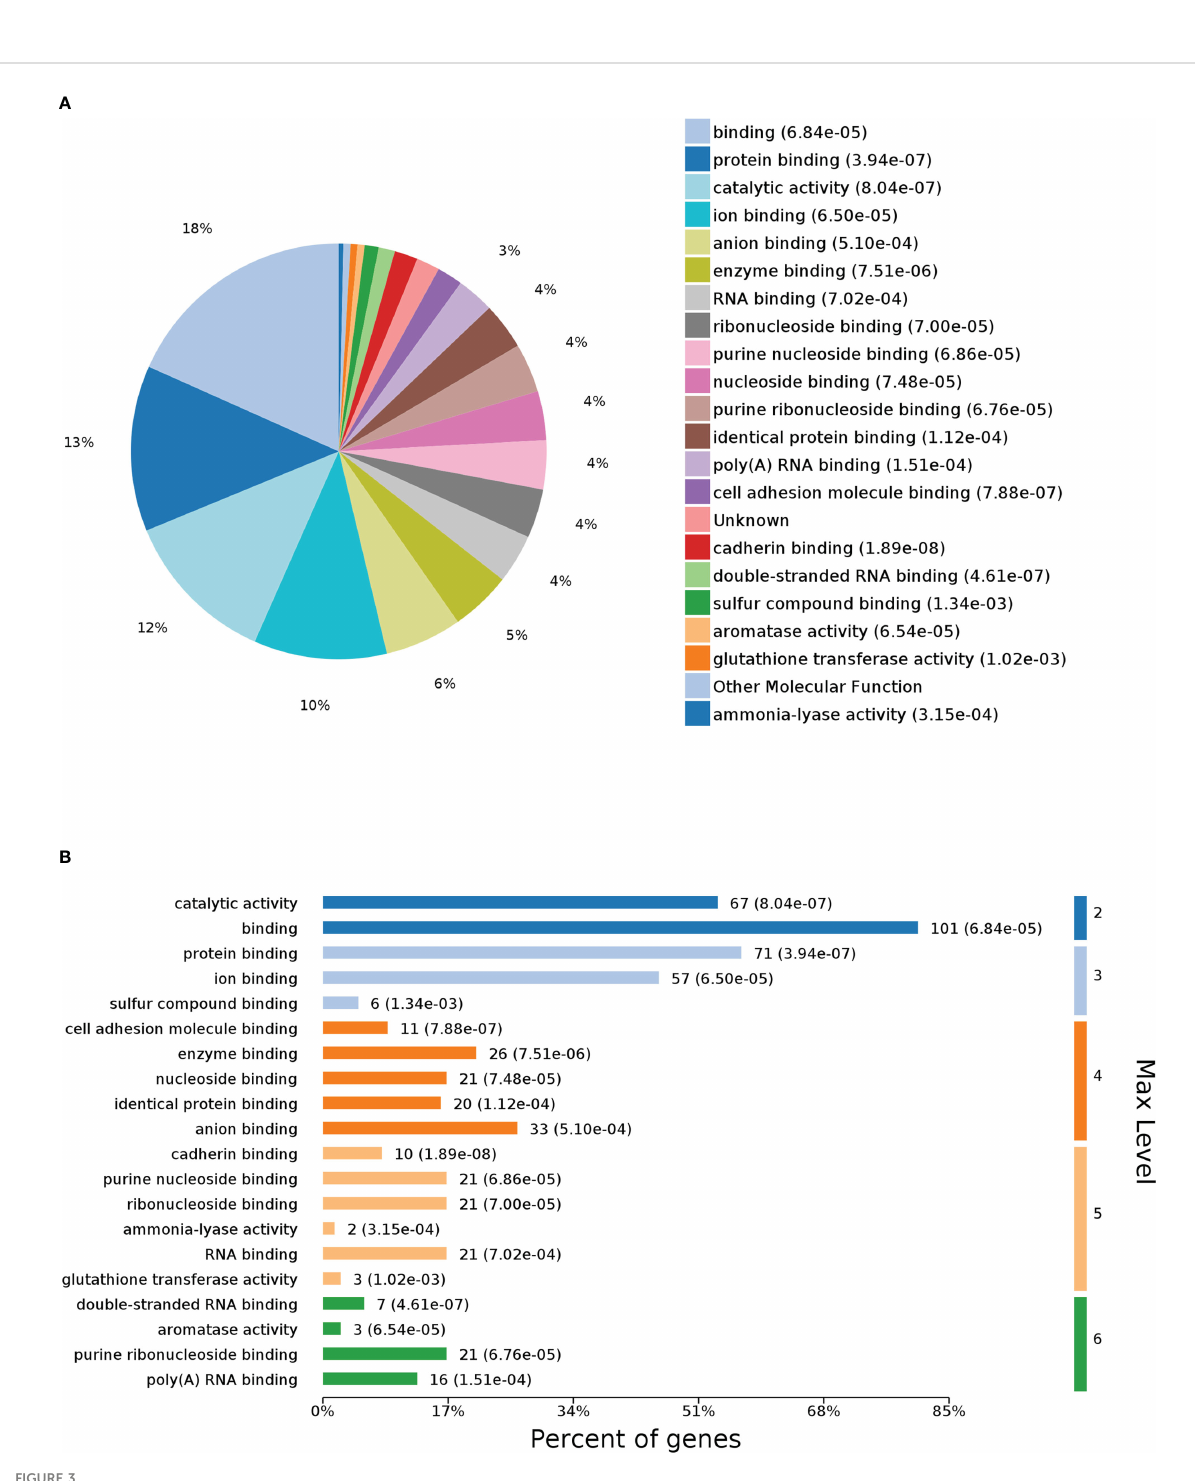
FIGURE 3 Gene Ontology (GO) enrichment analysis of molecular function for DEPs. (A) Pie chart of DEP-enriched GO terms for molecular function (MF). (B) Max level for